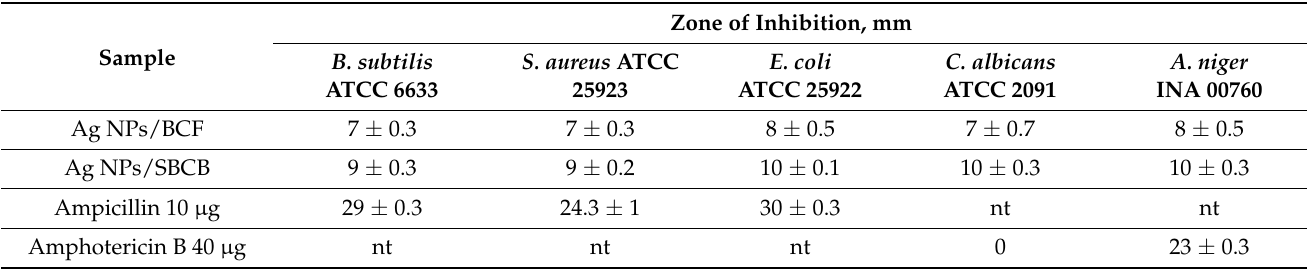
Zone of Inhibition, mm